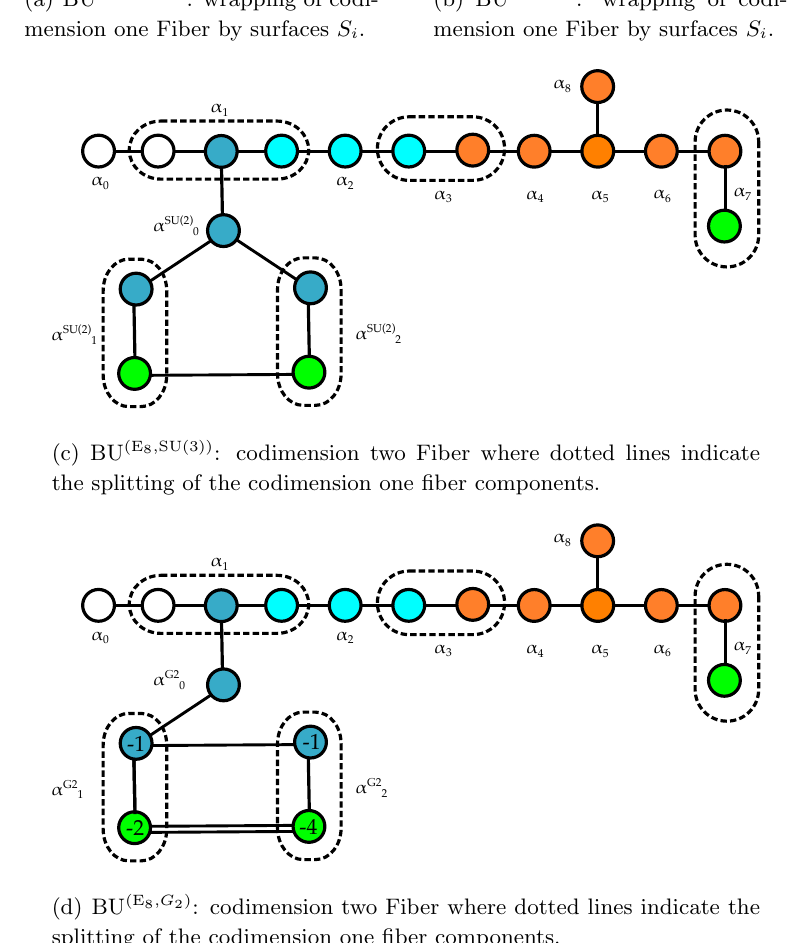
Figure 9 . Example blow-up for (E 8 ; SU(3)) and (E 8 ; G 2 ). The gauge theory description has rank 4 gauge group, corresponding to the four surface components S i . The (cid:12)rst image shows the a(cid:14)ne E 8 and SU(3) and how the S i wrap these (half-wrapping corresponding to self-intersection ( (cid:0) 1), full wrapping to ( (cid:0) 2)), see